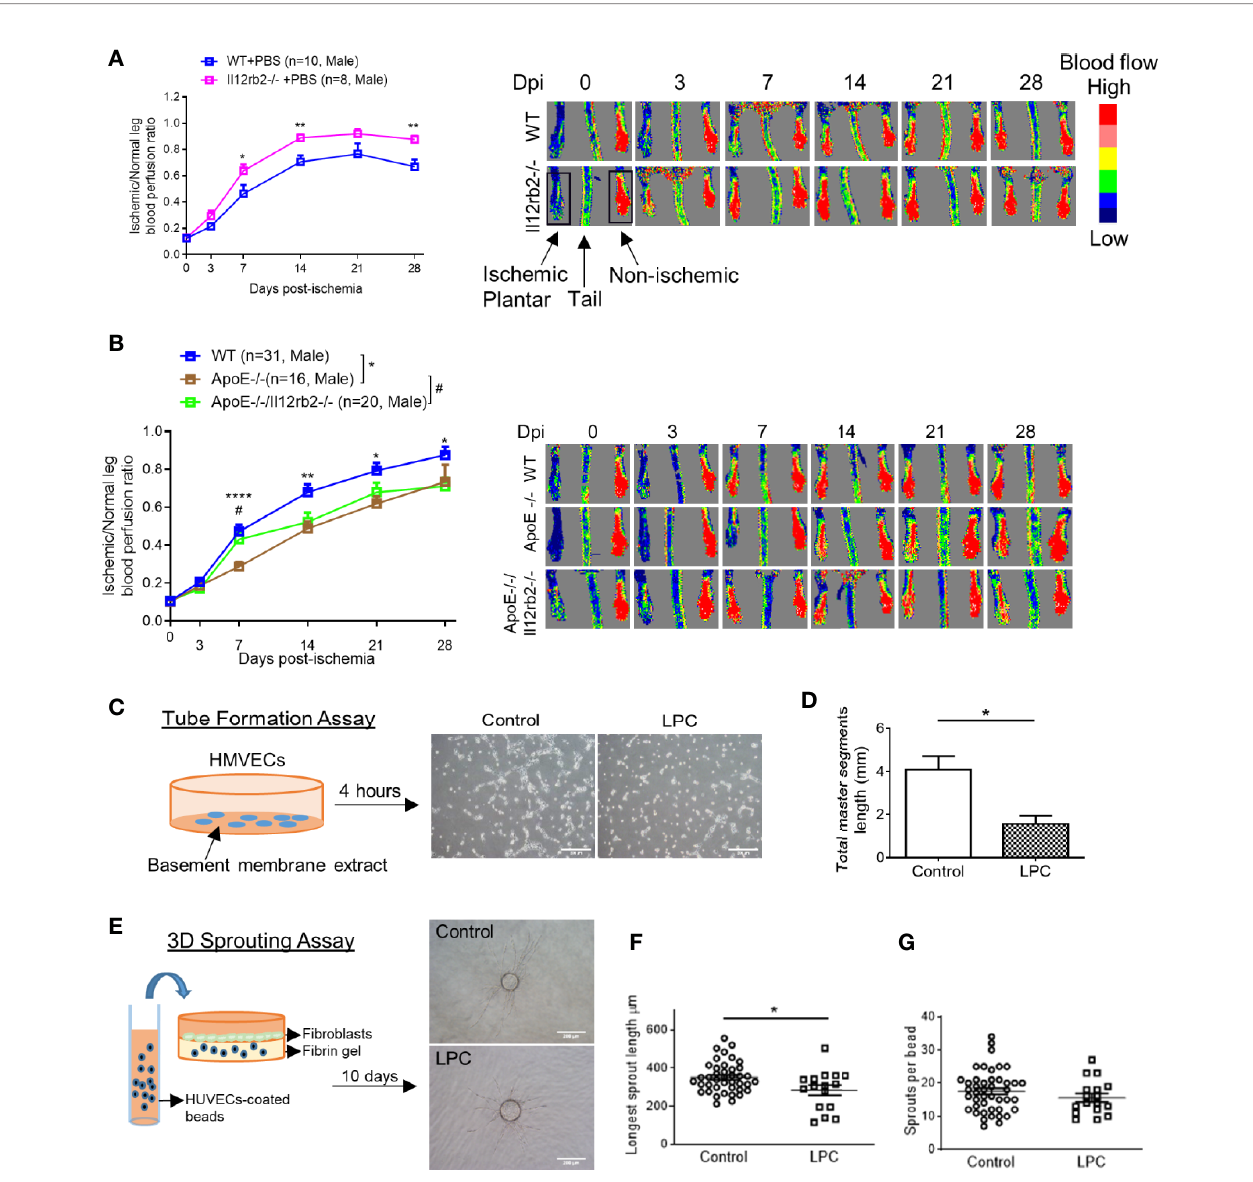
FIGURE 2 | Hindlimb ischemia (HLI)-induced angiogenesis is improved in Il12rb2 − / − mice, compared to WT, and in ApoE − / − /Il12rb2 − / − mice compared to ApoE − / − , where hyperlipidemia inhibits angiogenesis in vivo and in vitro . (A) Blood perfusion ratio of Il12rb − / − and WT mice in HLI model. Hindlimb blood fl ow was measured on day post-ischemia (dpi) 0, 3, 7, 14, 21, and 28 with the plantar looking up using a laser Doppler blood fl ow analyzer. Blood fl ow was quantitatively assessed by the ratio of mean fl ow signals of the ischemic to the non-ischemic plantar in black rectangular area. (B) Blood perfusion ratio of ApoE − / − /Il12rb2 − / − , ApoE − / − , and WT mice in HLI model. (C) Experimental schematics and representative images of human microvascular endothelial cell (HMVEC) tube formation. Cells were seeded on Matrigel for 4 h with or without 30 µM of LPC treatment. (D) Total master segment length was measured with an ImageJ package of Angiogenesis Analyzer. (E) Experimental schematics and representative images of 3D sprouting assay. Human umbilical vein endothelial cell (HUVEC)-coated beads were embedded in fi brin gel for 10 days with or without 30 µM of LPC treatment. (F) Statistics of longest sprout length. (G) Statistics of sprouts per bead. Sprouts per bead and longest sprout length were manually measured blinded to the treatment. Scale bars are 200 µm in (C , E) . All animal results were collected from male mice. Data are presented as mean ± SEM. *p < 0.05; **p < 0.01; ****p < 0.0001; # P <